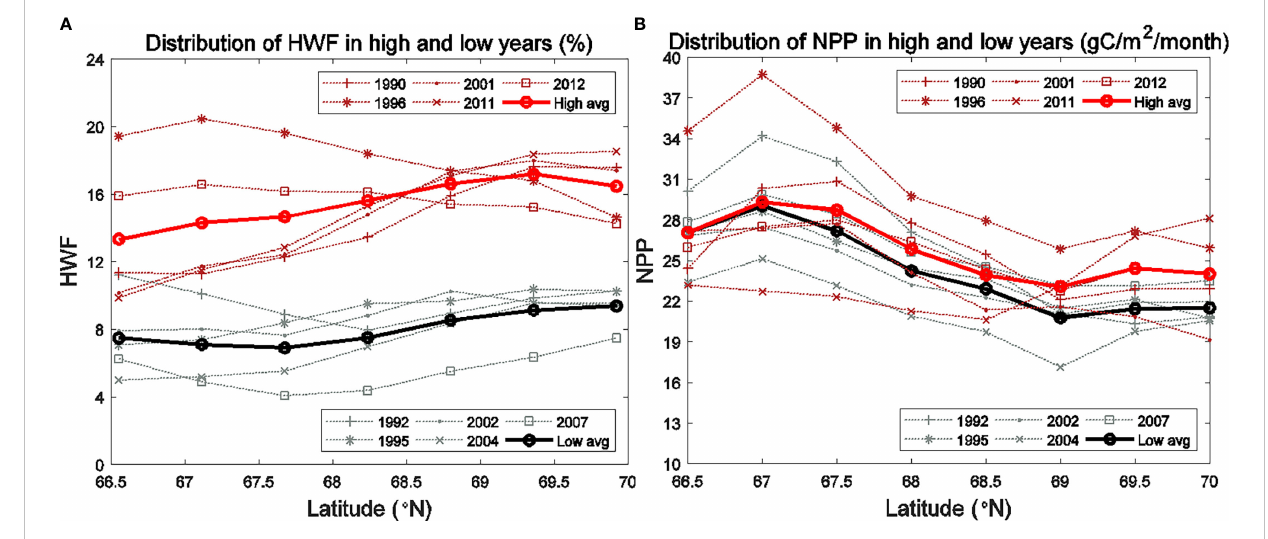
FIGURE 8 Seasonally (June to September) averaged (A) HWF and (B) modeled vertically-integrated NPP for the high (1990, 1996, 2001, 2011, 2012) and low (1992, 1995, 2002, 2004, 2007) HWF years in the